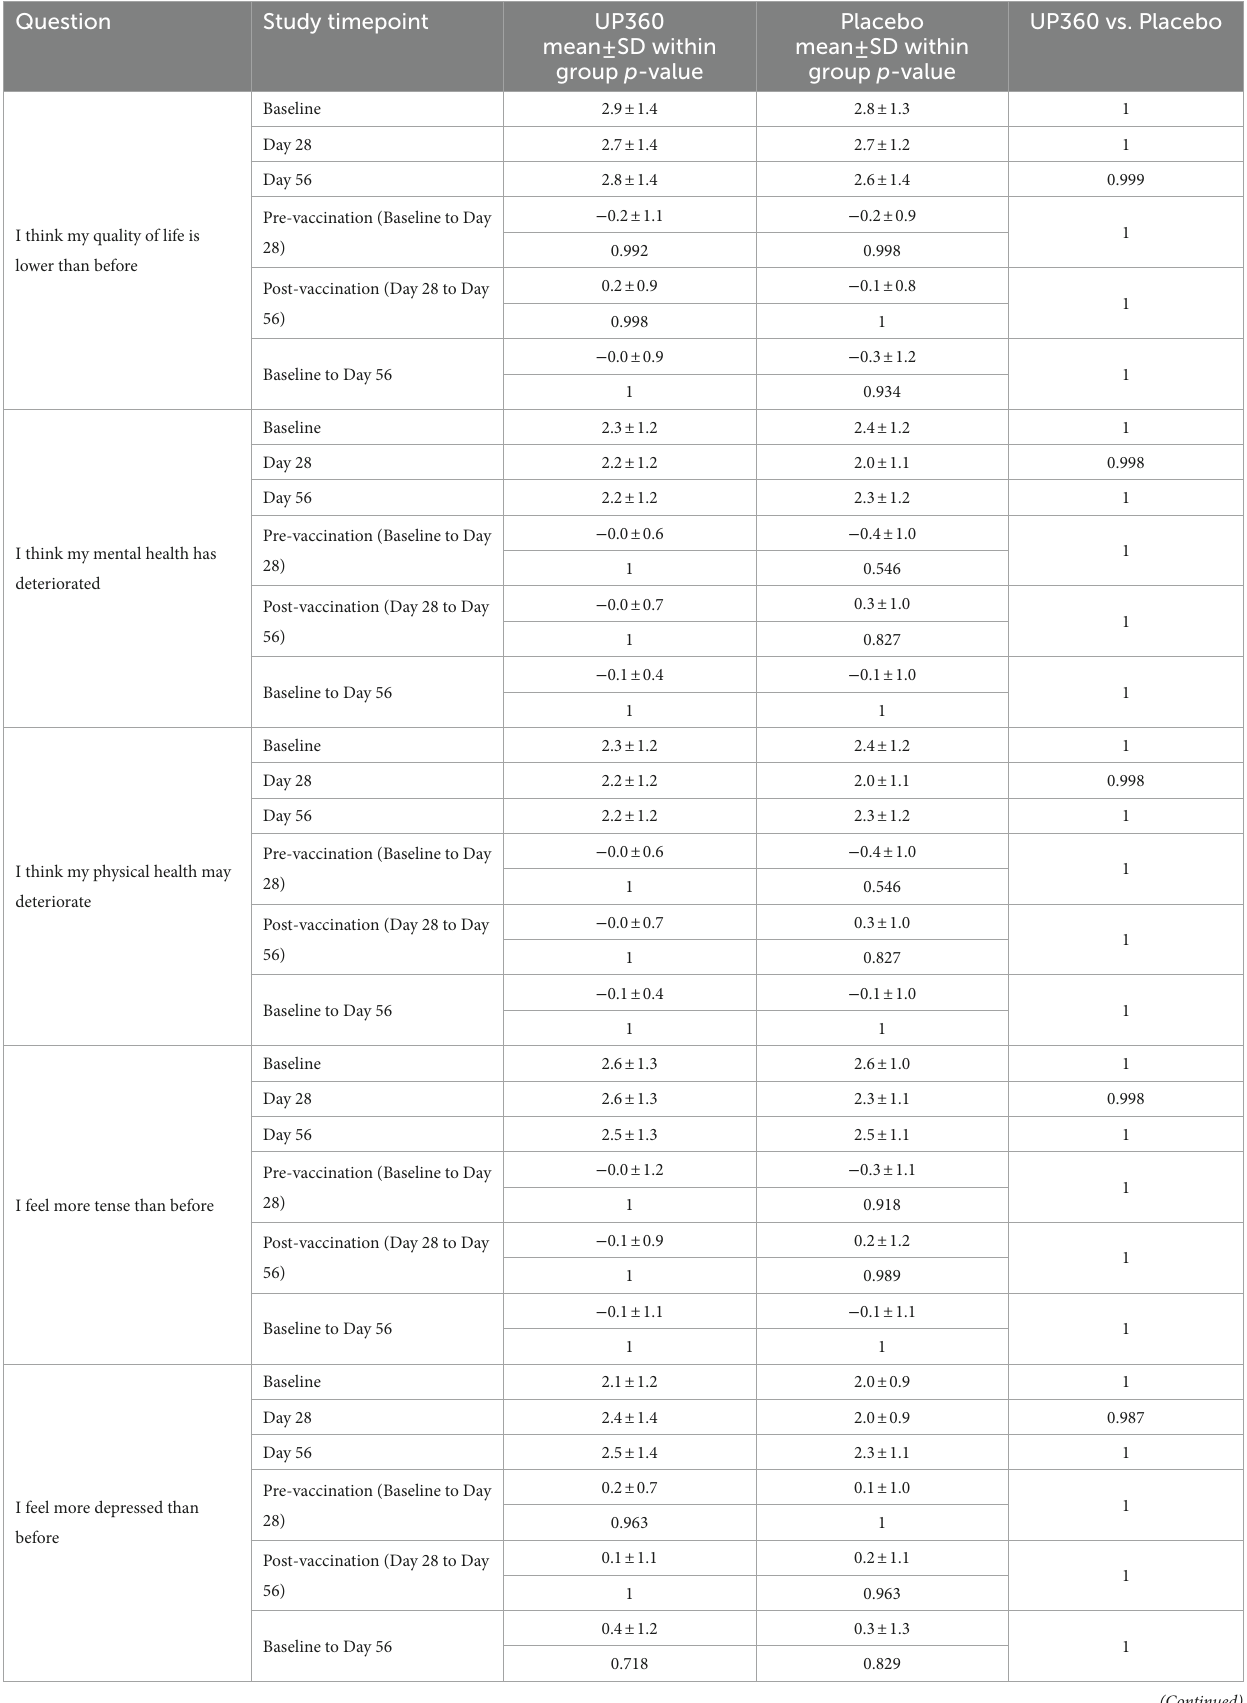
TABLE 3 Impact of COVID-19 on participant’s quality of life (QoL) assessed by the COVID-19 impact on QoL questionnaire (ITT) ( n = 50). Question Study timepoint UP360